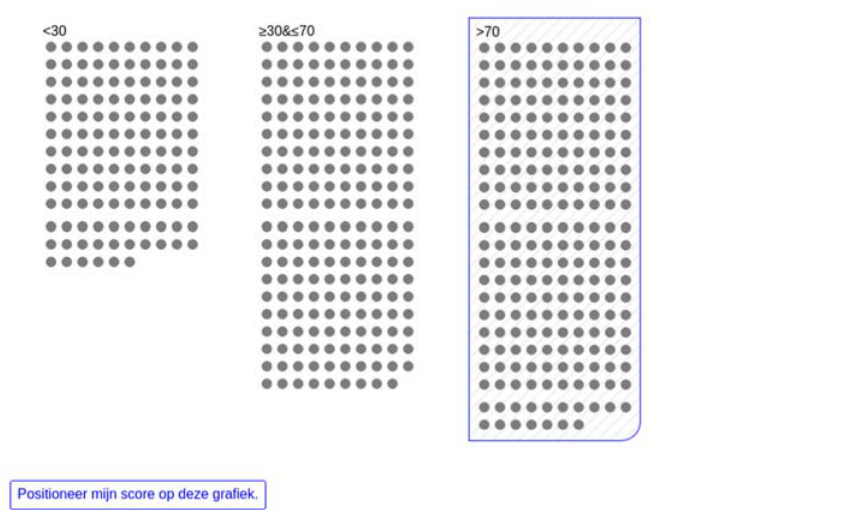
Figure 3. Visualization of